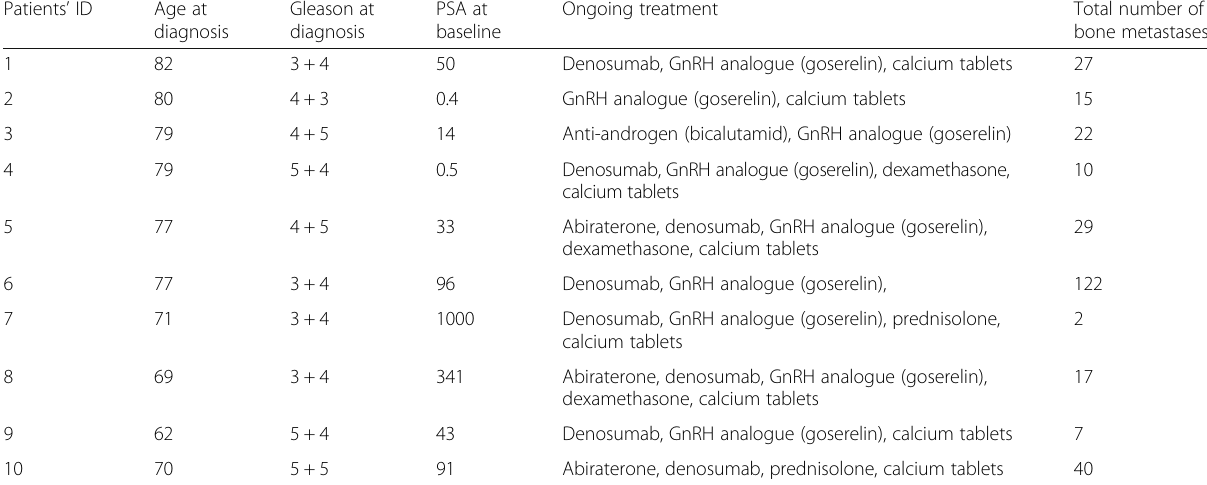
Table 1 Patient characteristics and total number of bone metastases with 18F-fluoride PET/CT uptake Patients ’ ID